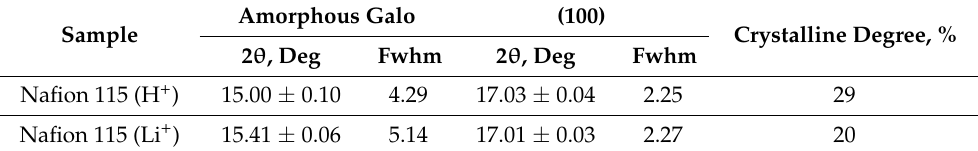
Figure 5. Wide-angle diffraction pattern of “dry” Nafion 115 membrane before ( a ) and after ( b ) lithiation. Table 1. X-ray characteristics of “dry” Nafion 115 membrane before and after lithiation.